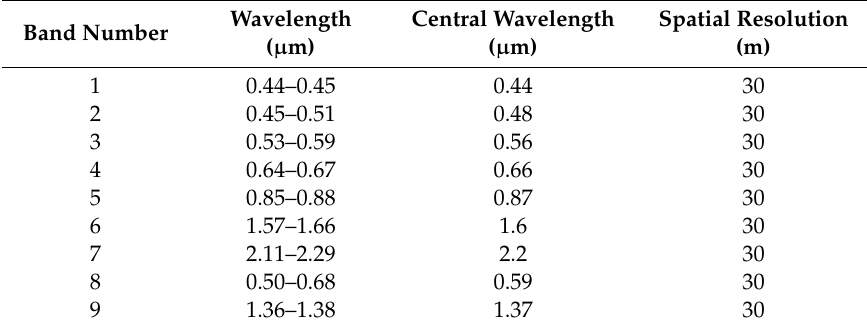
Table 2. Landsat–8 Operational Land Imager (OLI) characteristics